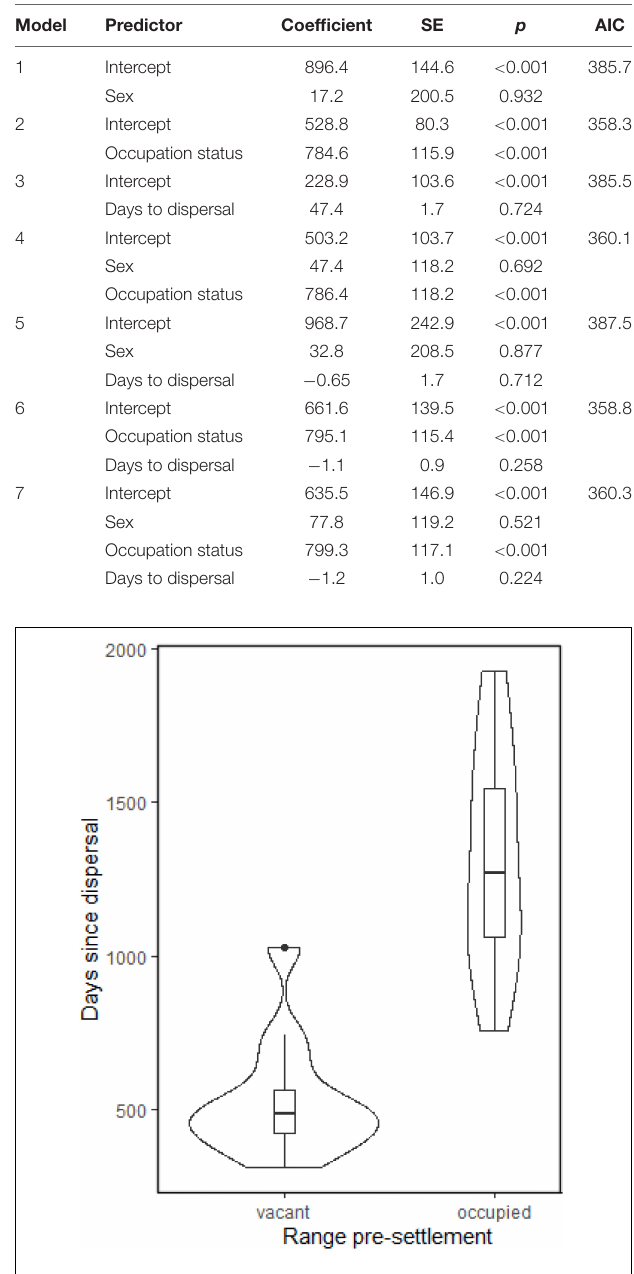
TABLE 3 | Results of seven general linear model (GLM) models examining AFTS (days since dispersal to settlement) with three predictor variables: the bird’s sex, the prior occupation status of the territory where a bird settled (vacant or occupied), and the duration of the bird’s PFDP (days to dispersal).